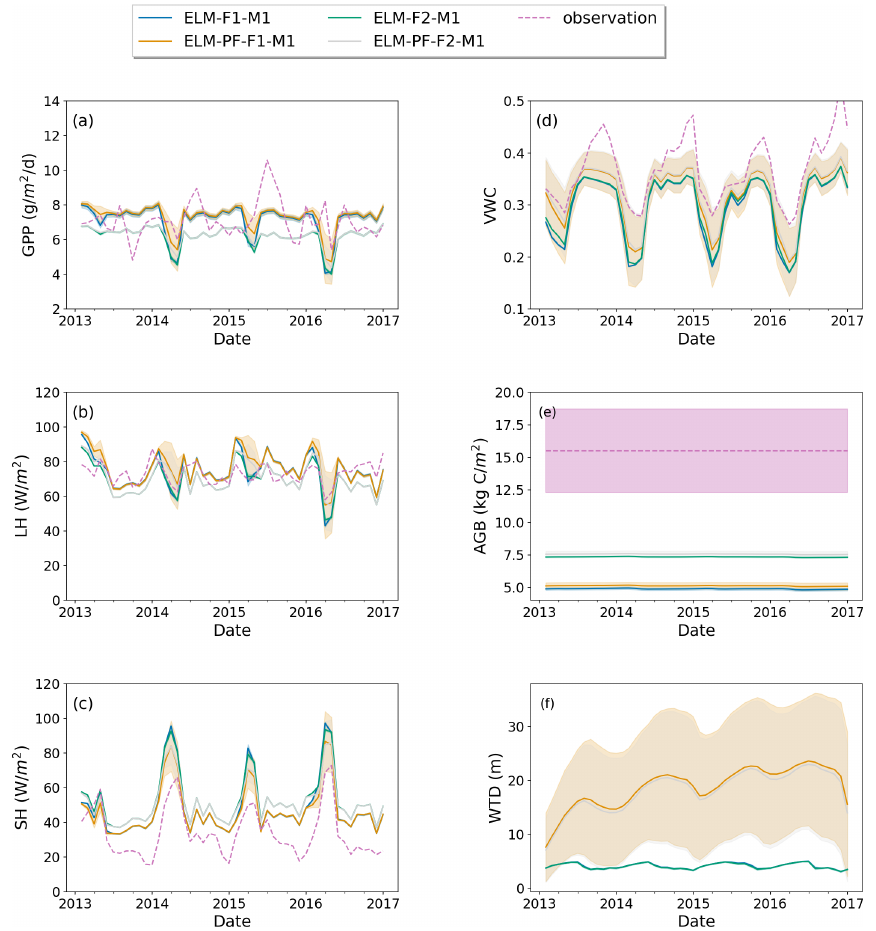
Figure 4. Simulated GPP (a) , latent heat flux (LH) (b) , sensible heat flux (SH) (c) , top 15cm volumetric water content (VWC) (d) , AGB (e) , and WTD (f) for simulations ELM-F1-M1, ELM-F2-M1, ELM-PF-F1-M1, and ELM-PF-F2-M1. Dashed line is the observation if available. Solid line is the spatial average, and the shaded area is the standard deviation over the simulation